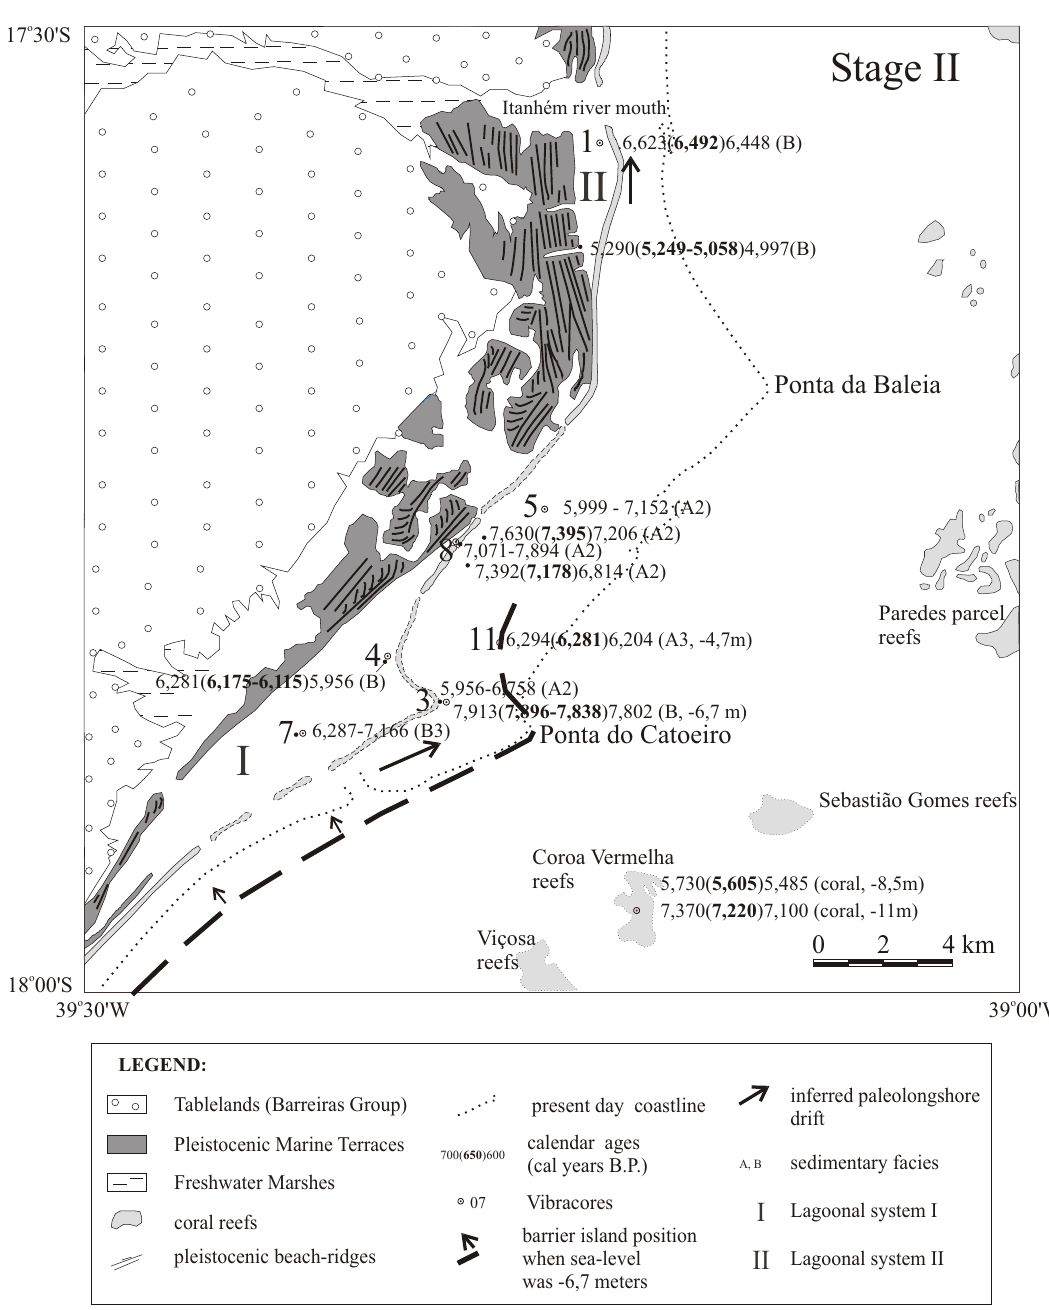
Fig. 10 – Quaternary evolution of the Caravelas strandplain: Stage II – Drowning of the Pleistocene strandplain during the Last Transgression (5,600 cal. years B.P./5,200 years C 14 B.P.).